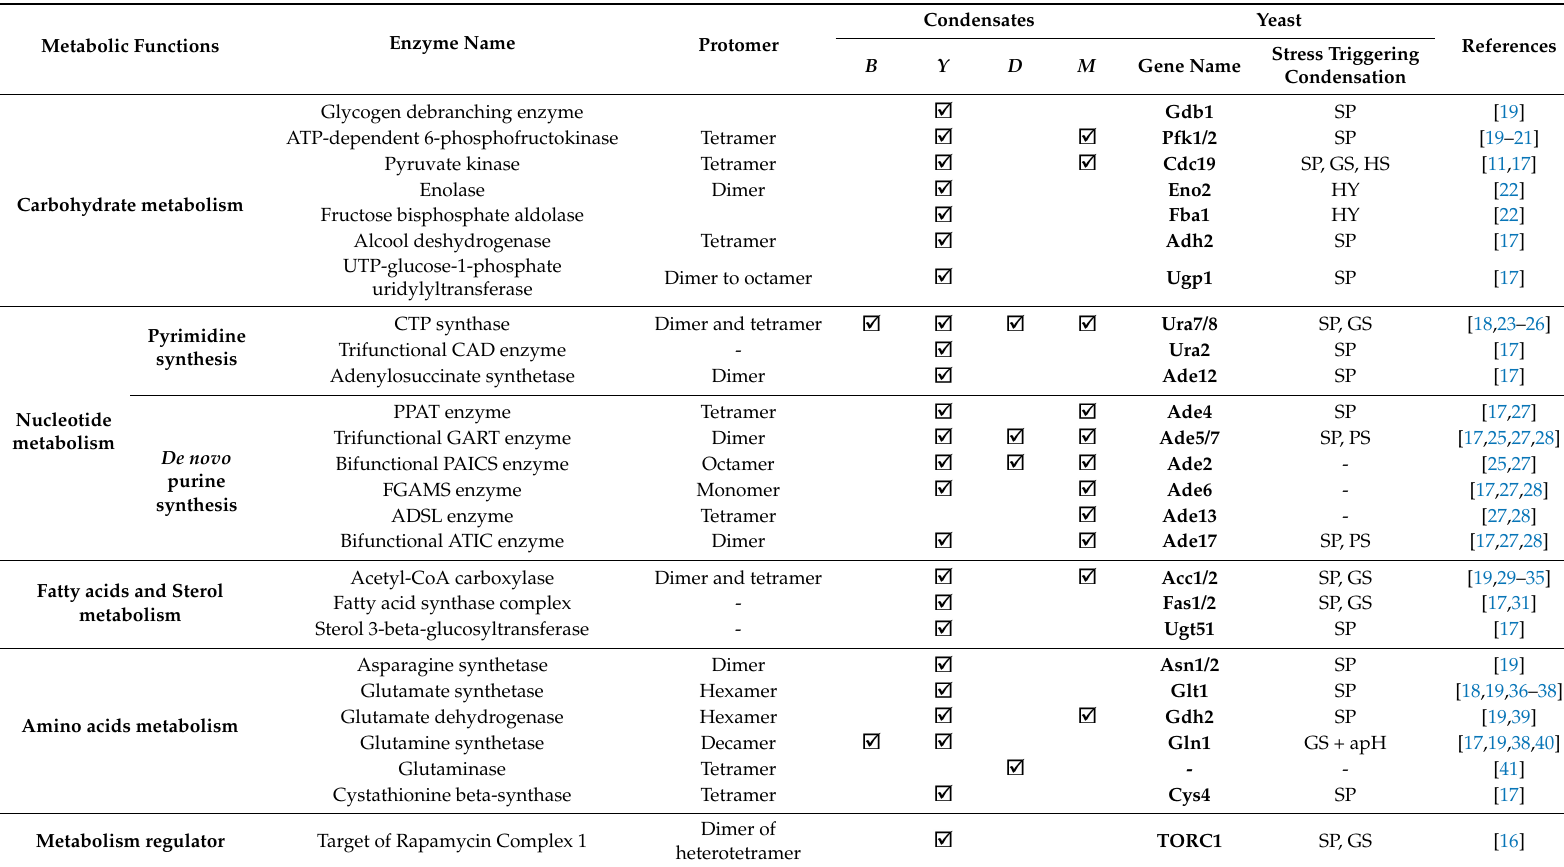
Table 1. Summary of metabolism-related enzymes observed to form condensates in bacteria (B), yeast (Y), drosophila (D) and mammals (M). Note that many of these enzymes function as oligomers, an attribute that likely contributes to their ability to form higher-order structures. ADSL: Adenylosuccinate lyase; ATIC: 5-aminoimidazole-4-carboxamide ribonucleotide transformylase and inosine monophosphate cyclohydrolase; CAD: carbamoyl-phosphate synthetase 2, aspartate transcarbamylase and dihydroorotase; FGAMS: Formylglycinamidine-ribonucleotide synthetase; GART: glycinamide ribotide and aminoimidazole ribotide synthetases; PAICS: Phosphoribosylaminoimidazole carboxylase; PPAT: Phosphoribosylpyrophosphate amidotransferase. Stresses that trigger condensate formation in yeast: Stationary phase (SP), glucose starvation (GS), purine starvation (PS), acidic pH (apH), heat shock (HS) and hypoxia